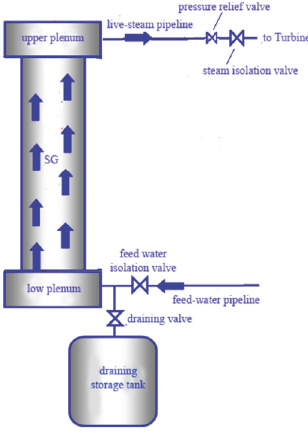
Figure 2: Illustration of the HTR-PM secondary loop.